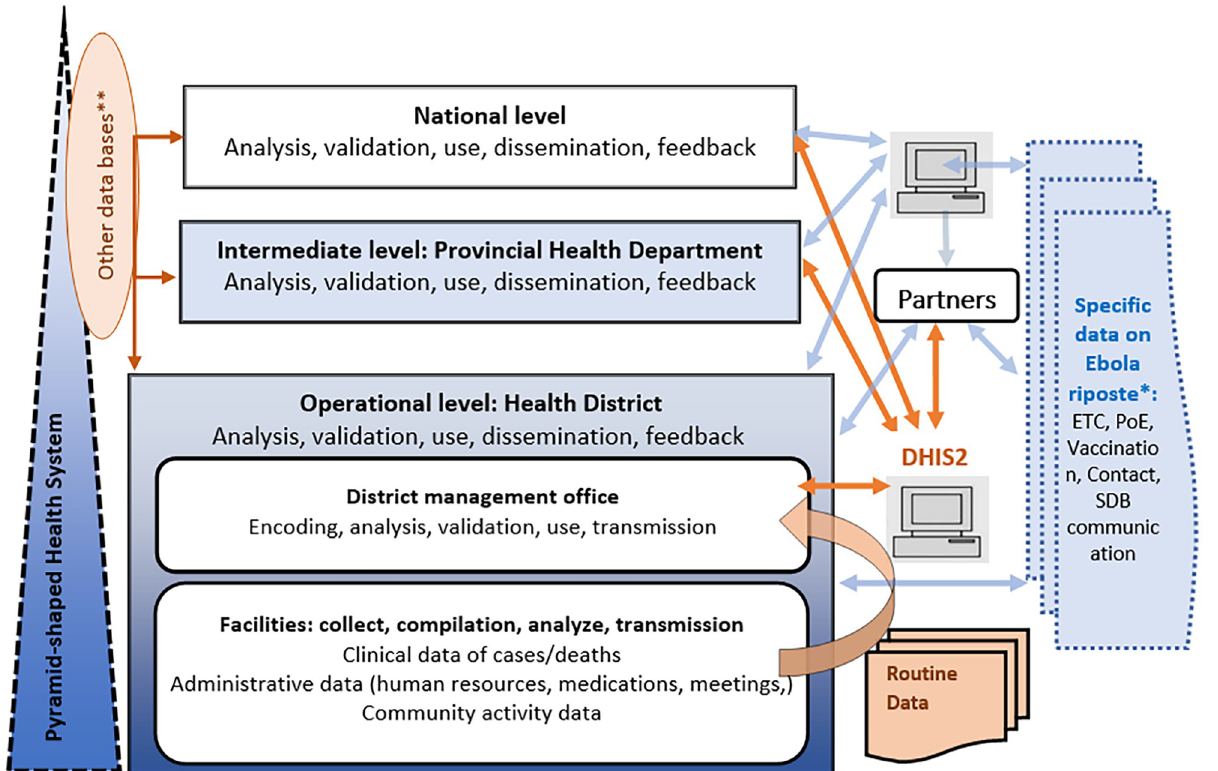
Fig 3. Data flow during the 2018–2020 EVD outbreak, North Kivu Province, Eastern DRC. DHIS2: second generation of the District Health Information System . � ETC: Ebola treatment center , PoE: point of entry , SDB: safe and dignified burials . �� Weekly surveillance data , data from Specific